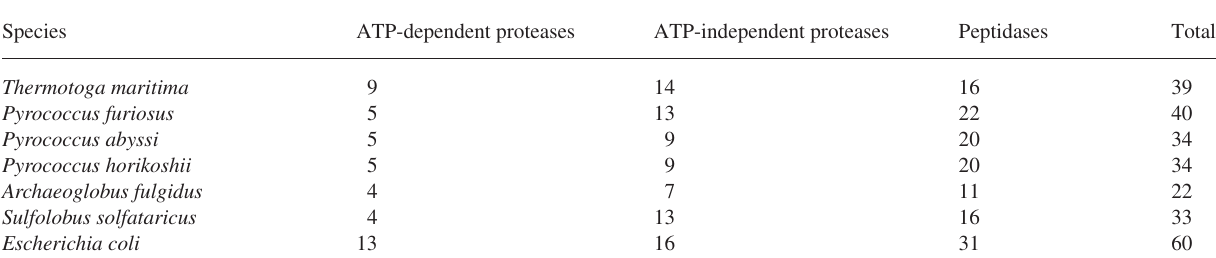
Table 2. Protease-related genes in selected microorganisms.